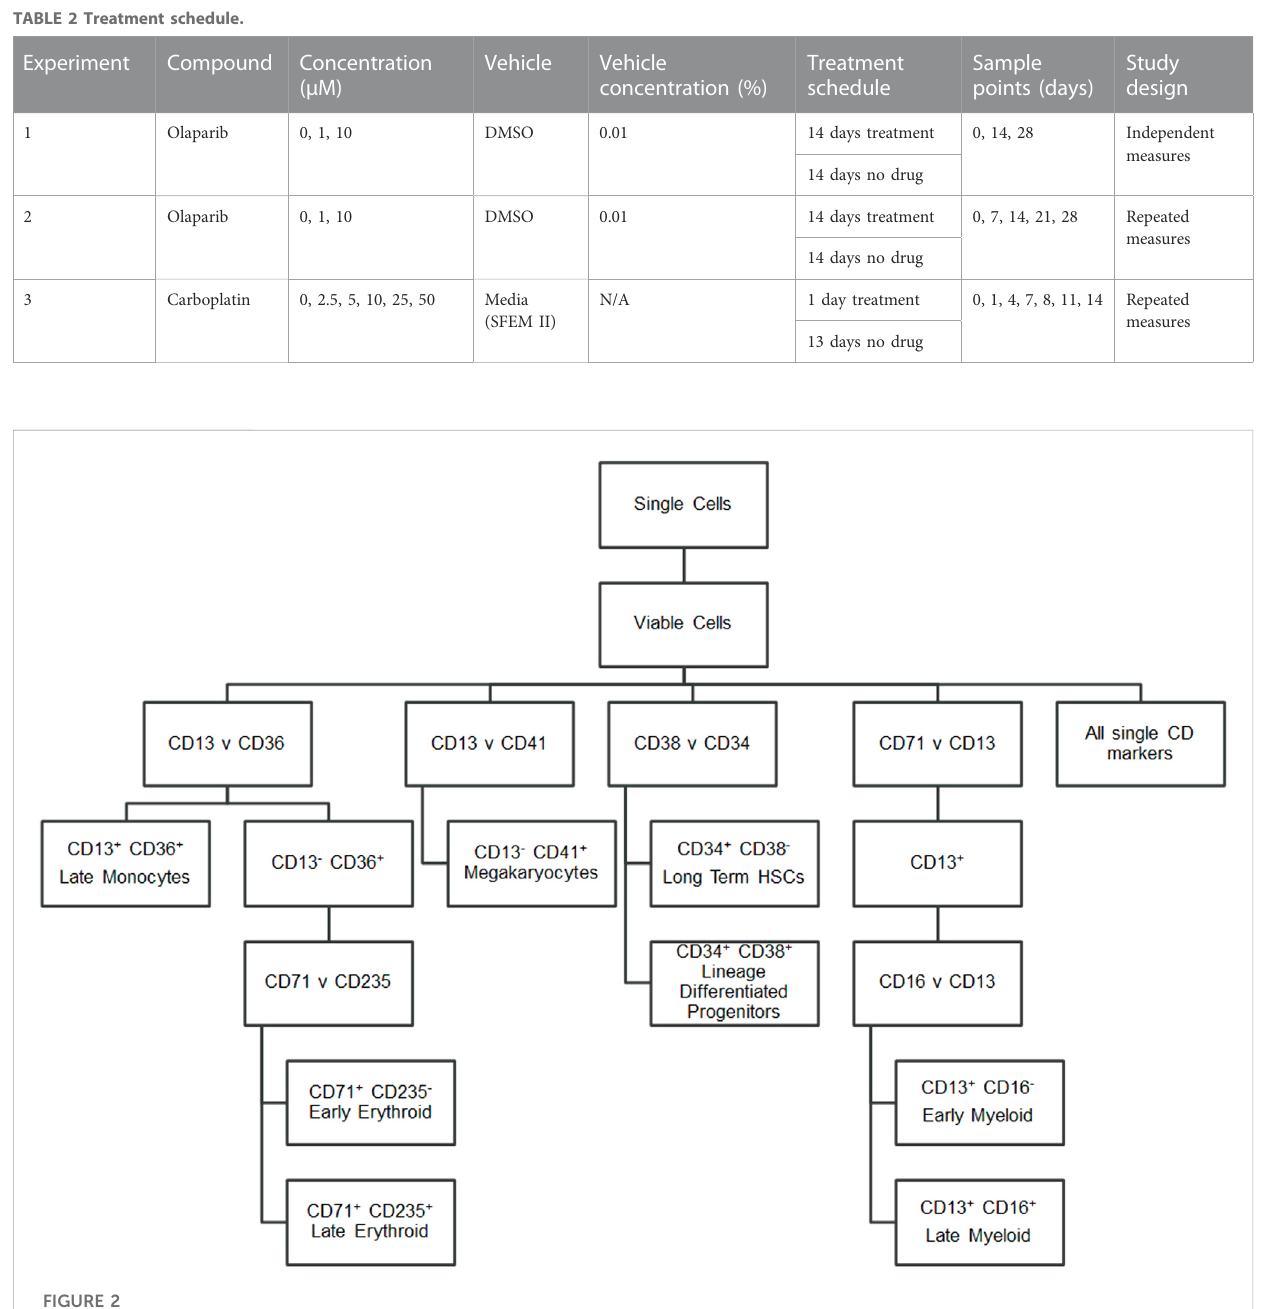
FIGURE 2 Flow cytometry gating strategy. Hierarchy showing the markers gated to identify cell